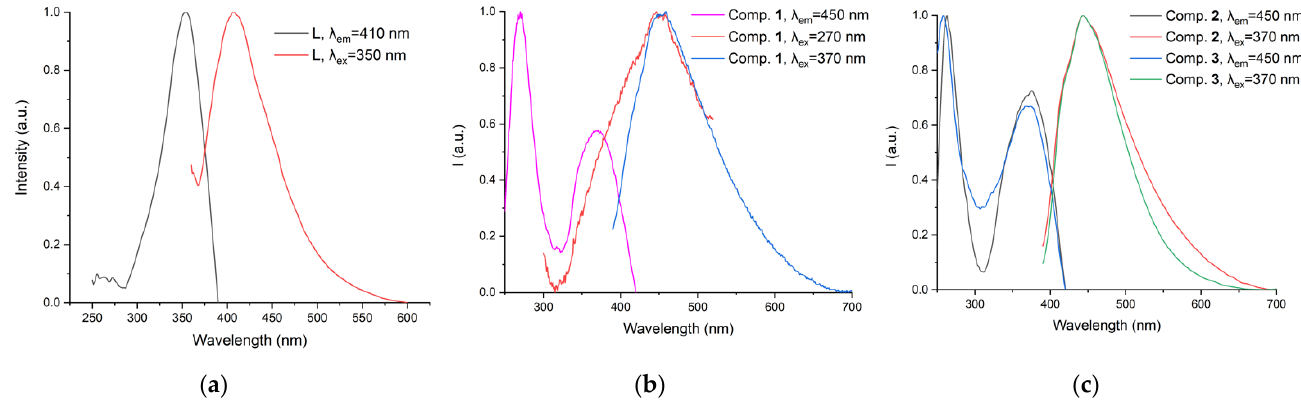
Figure 7. Normalized excitation and emission spectra of the free ligand L ( a ), compound 1 ( b ) and compounds 2 , 3 ( c ).